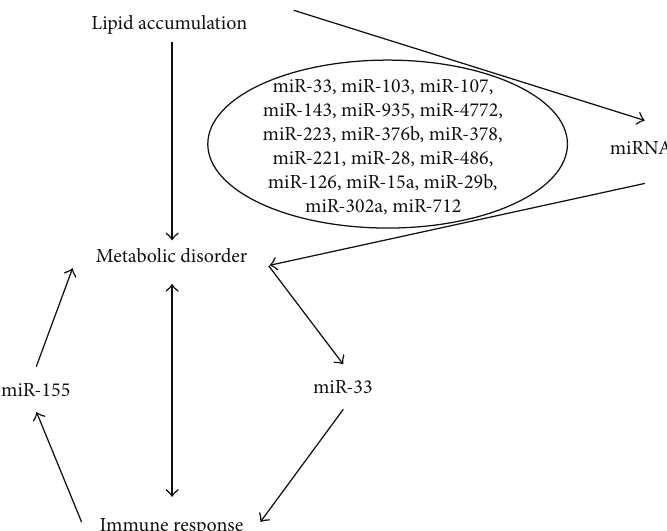
Figure 2: Role of miRNAs in obesity-induced metabolic disorder and immune response. Many miRNAs are regulated by lipid accumulation and play a mediatory e ff ect in coupling obesity and metabolic disorder. Moreover, they also mediate the induction of immune response. Here, we illustrated two typical miRNAs to show the critical role of miRNAs in the interactions of metabolic disorder and immune